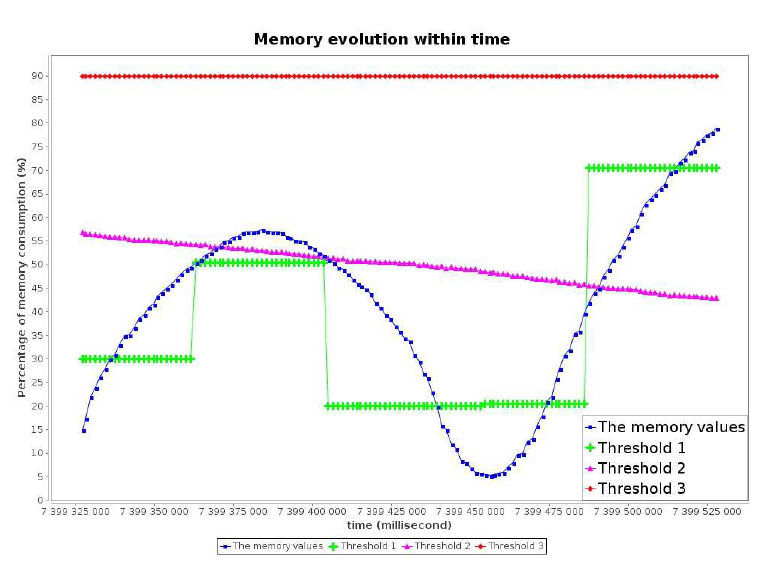
Figure 7. Application of threshold on the memory context